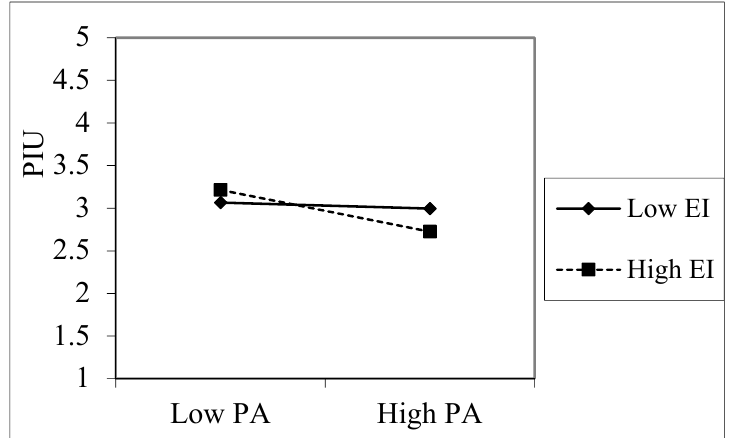
Figure 4. The interaction effect of peer attachment with emotional intelligence on pathological Internet use. PA = peer attachment, PPR = perceived personal rejection, EI = emotional intelligence, PIU = pathological Internet use.